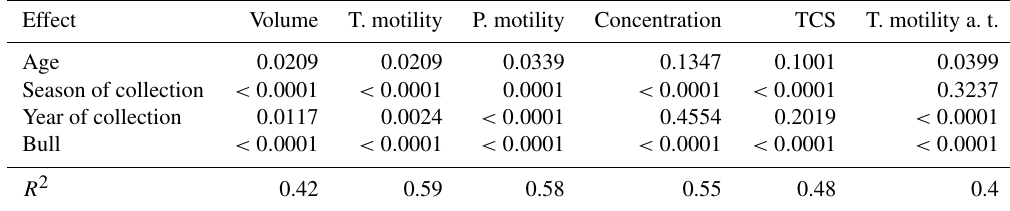
Table 2. Significance ( p -values) of effects of explanatory variables on dependent variables.